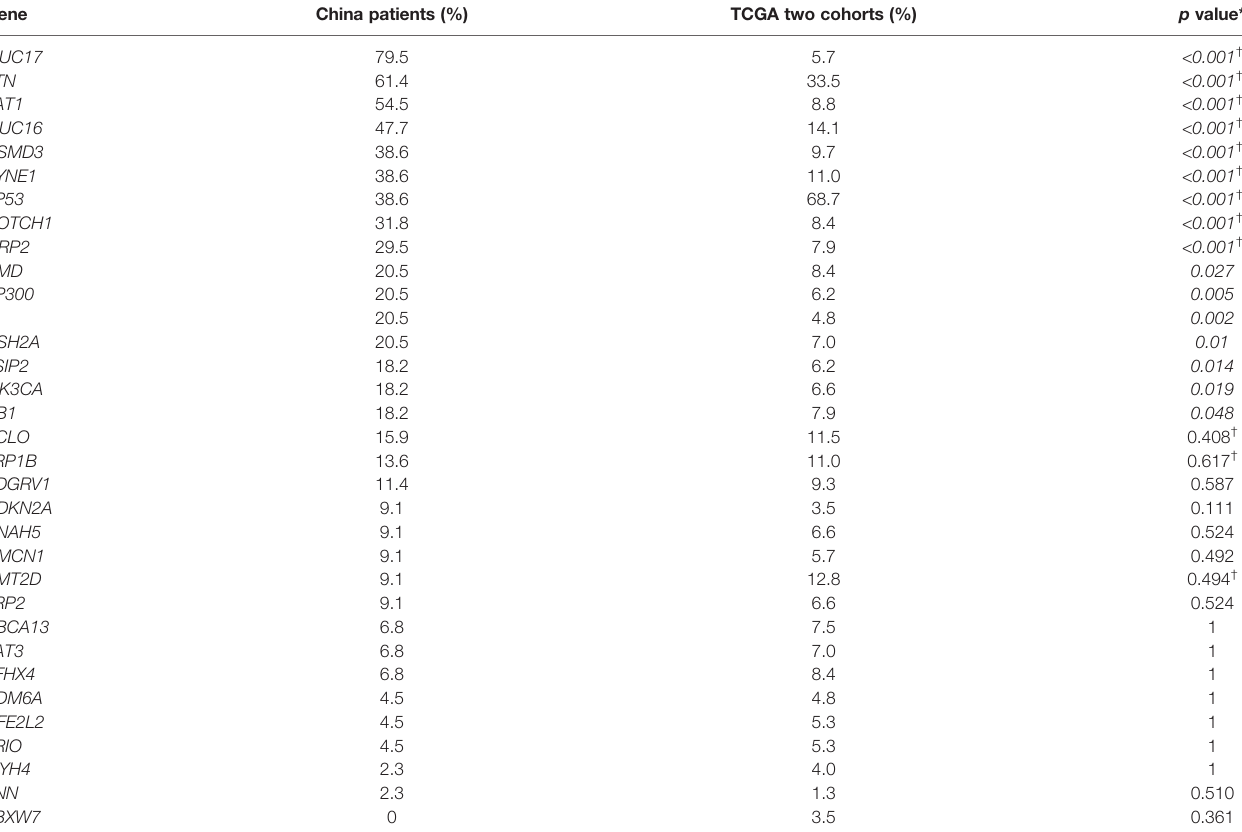
TABLE 4 | Comparison of gene mutation rates in esophageal squamous cell carcinoma patients of the present China study group and The Cancer Genome Atlas (TCGA) cohorts. Gene China patients (%) TCGA two cohorts (%)